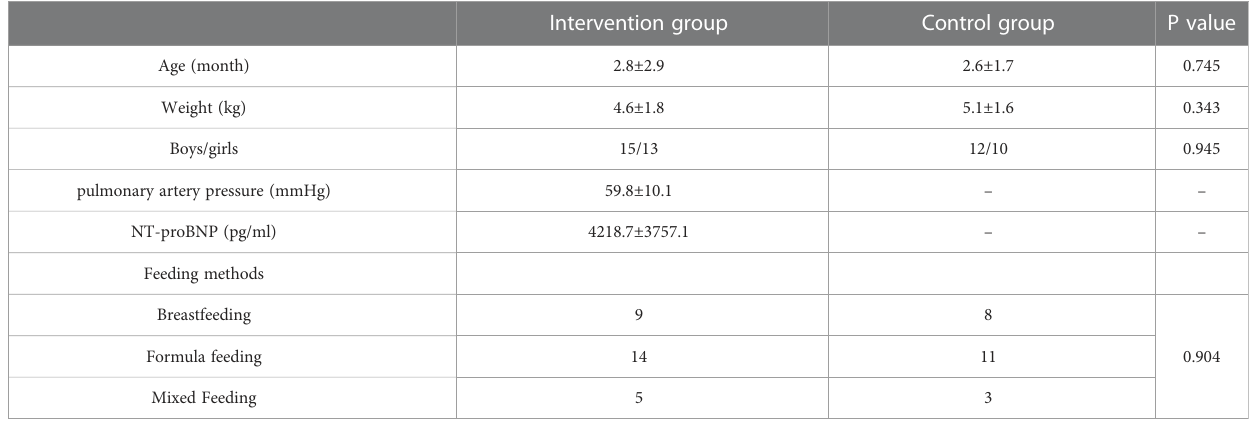
TABLE 1 Comparison of general data between the two